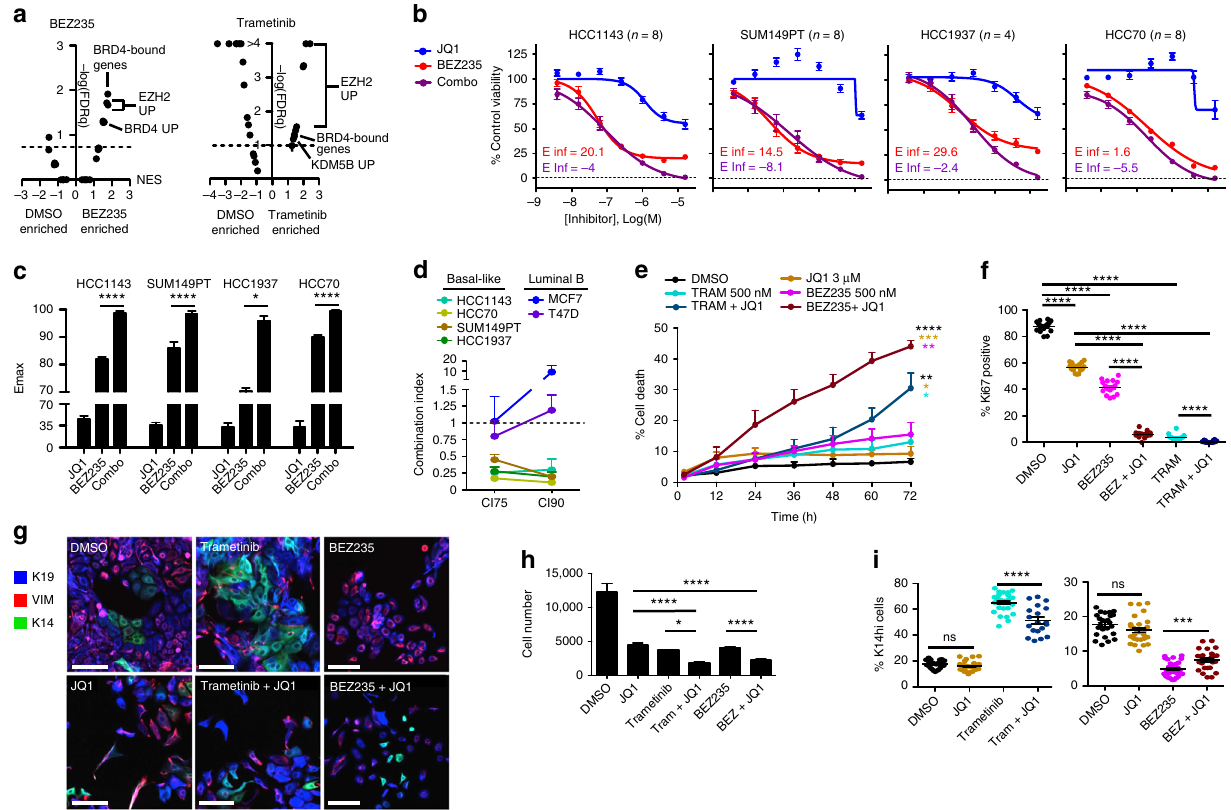
Fig. 5 BET inhibitor combinations improve cell kill and suppress DTP transition. a GSEA results as a volcano plot of Normalized Enrichment Score (NES, x -axis) vs. FDRq ( − log, y -axis) examining 25 chromatin modi fi er enzyme activity-related genesets, enrichment compared between DMSO and 1 μ M BEZ235 (left), or DMSO and 1 μ M Trametinib (right) in HCC1143 cells treated for 6 days. Select top-enriched genesets are labeled. b Dose – response curves show the ef fi cacy of BEZ235 alone (red), JQ1 alone (blue), or a combination of the two agents (purple, equimolar ratio) in four basal-like cell lines using a colorimetric proliferation assay. E-in fi nity (Einf) values of single agent BEZ235 (red) and BEZ235 + JQ1 (purple) are displayed. n = 4 – 8 with SEM. c Maximal inhibition (Emax) by the agents shown in ( b ) is displayed for each basal-like cell line, asterisks depict signi fi cant gains in Emax with JQ1 + BEZ235 compared to BEZ235 alone, * P < 0.05, ** P < 0.01, *** P < 0.001, **** P < 0.0001. d Graph showing combination indices for the BEZ235 + JQ1 drug combination at 75% (CI75), and 90% (CI90) inhibitory doses for four basal-like and two luminal B BCCLs, n = 5 with SEM. e Graph showing the percent of dying cells (YO-PRO-1 + ) in HCC1143 following the addition of 1 μ M BEZ235, 1 μ M Trametinib, 2 μ M JQ1, the combinations of these agents, or a DMSO control. Asterisks denote signi fi cant gains in percent cell death in combination-treated cells vs. single agent BEZ235 or Trametinib, n = 3 with SEM. f Graph showing the percent of Ki67 positive HCC1143 cells following 72 h of DMSO, 2 μ M JQ1, 1 μ M Trametinib, 1 μ M BEZ235, or combinations with JQ1. Asterisks denote signi fi cant difference in Ki67 + frequency, n = 16 with SD. g IF images of HCC1143 cells following 72 h exposure to DMSO, 400 nM BEZ235, 400 nM Trametinib, 8 μ M JQ1, or the combination of these agents, scale bars = 100 μ m. h , i Graphs show total cell number and the frequency of K14 hi cells following the treatments outlined in ( e ). Asterisks denote signi fi cant change in the frequency of K14 hi cells, or cell number, n = 27 with